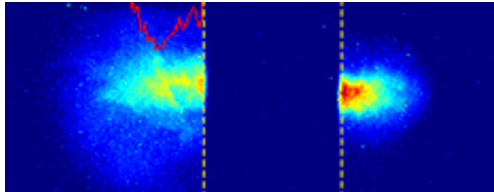
FIG. 8. Photographic images of (a) a diagonal cut CWG segment at 100 times magnification, (b) a 3D rendering of the diagonal cut segment, and (c) a profile graph of the corrugation. All dimensions are in microns.